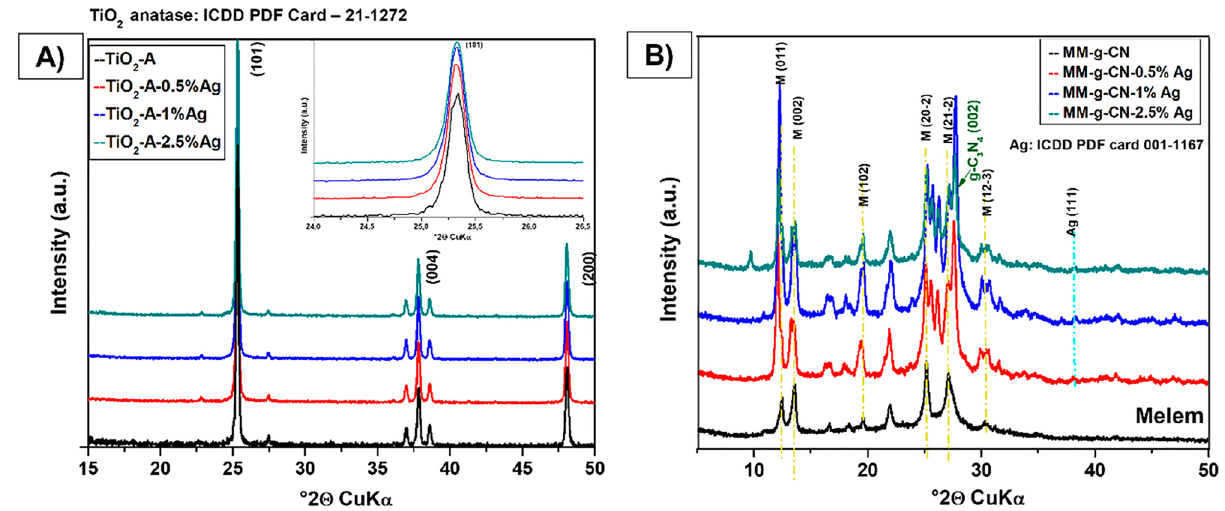
Figure 2. XRD patterns of: ( A ) TiO 2 samples pure and modified with various amounts of silver. The most intensive peaks have noted lattice planes with Miller indices and detail of anatase (101) most intensive peak slight changes in position, and ( B ) melem (MM)/g-C 3 N 4 pure and modified with 3 concentrations of Ag in composition, where the most intensive peaks of the evaluated phases are noted lattice planes with Miller (Fig. S1A,B), Raman and FTIR (Figs. S2A,B, S3A,B), EDS with SEM (Figs. S7A,B, S8A–G), PL spectroscopy (Fig. S4) and elemental analysis (Table 1) are shown in Supplementary materials.